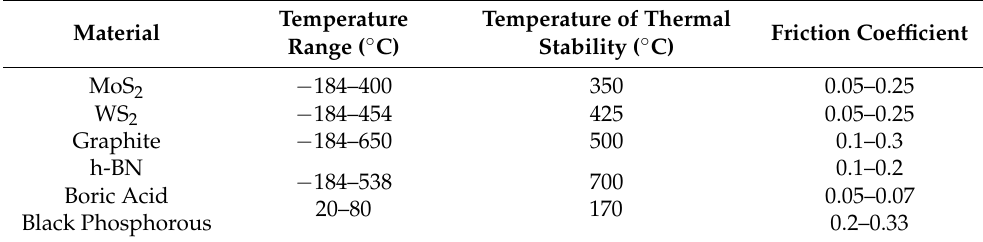
Table 3. Thermal stability and temperature range of application of some solid lubricants’